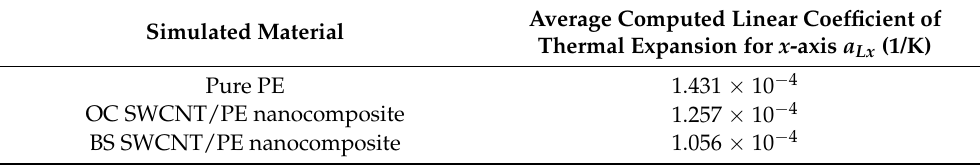
Table 1. The computed values of the linear coefficient of thermal expansion a Lx for the three materials and the temperature range from 300–400